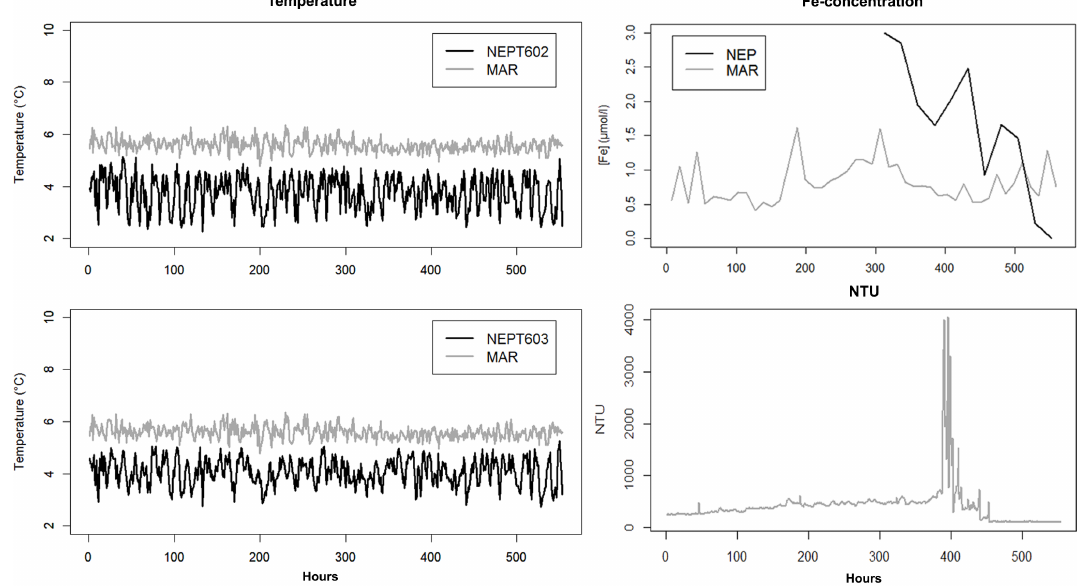
Figure 5. Short-term environmental variables (23 days) averaged per hour during the imagery analysis period. Variables measured at both deployment sites are presented in the same graphic (temperature and Fe). Fe has a daily frequency for the MAR but a 12h frequency for the NEP and recording times differ. NTU (nephelometric turbidity units) was only available for the MAR. Table 4. Mean, maximum and minimum temperatures as measured by the probes and, for comparison purposes, rescaled to ambient seawater temperature (italic values). See Fig. 5 for significant differences in raw temperature values. Variance and standard deviations are presented as well. Bold values represent the highest values, which tend to change if rescaled to ambient seawater temperature or not. Mean ( ◦ C) Max ( ◦ C) Min ( ◦ C) Var SD